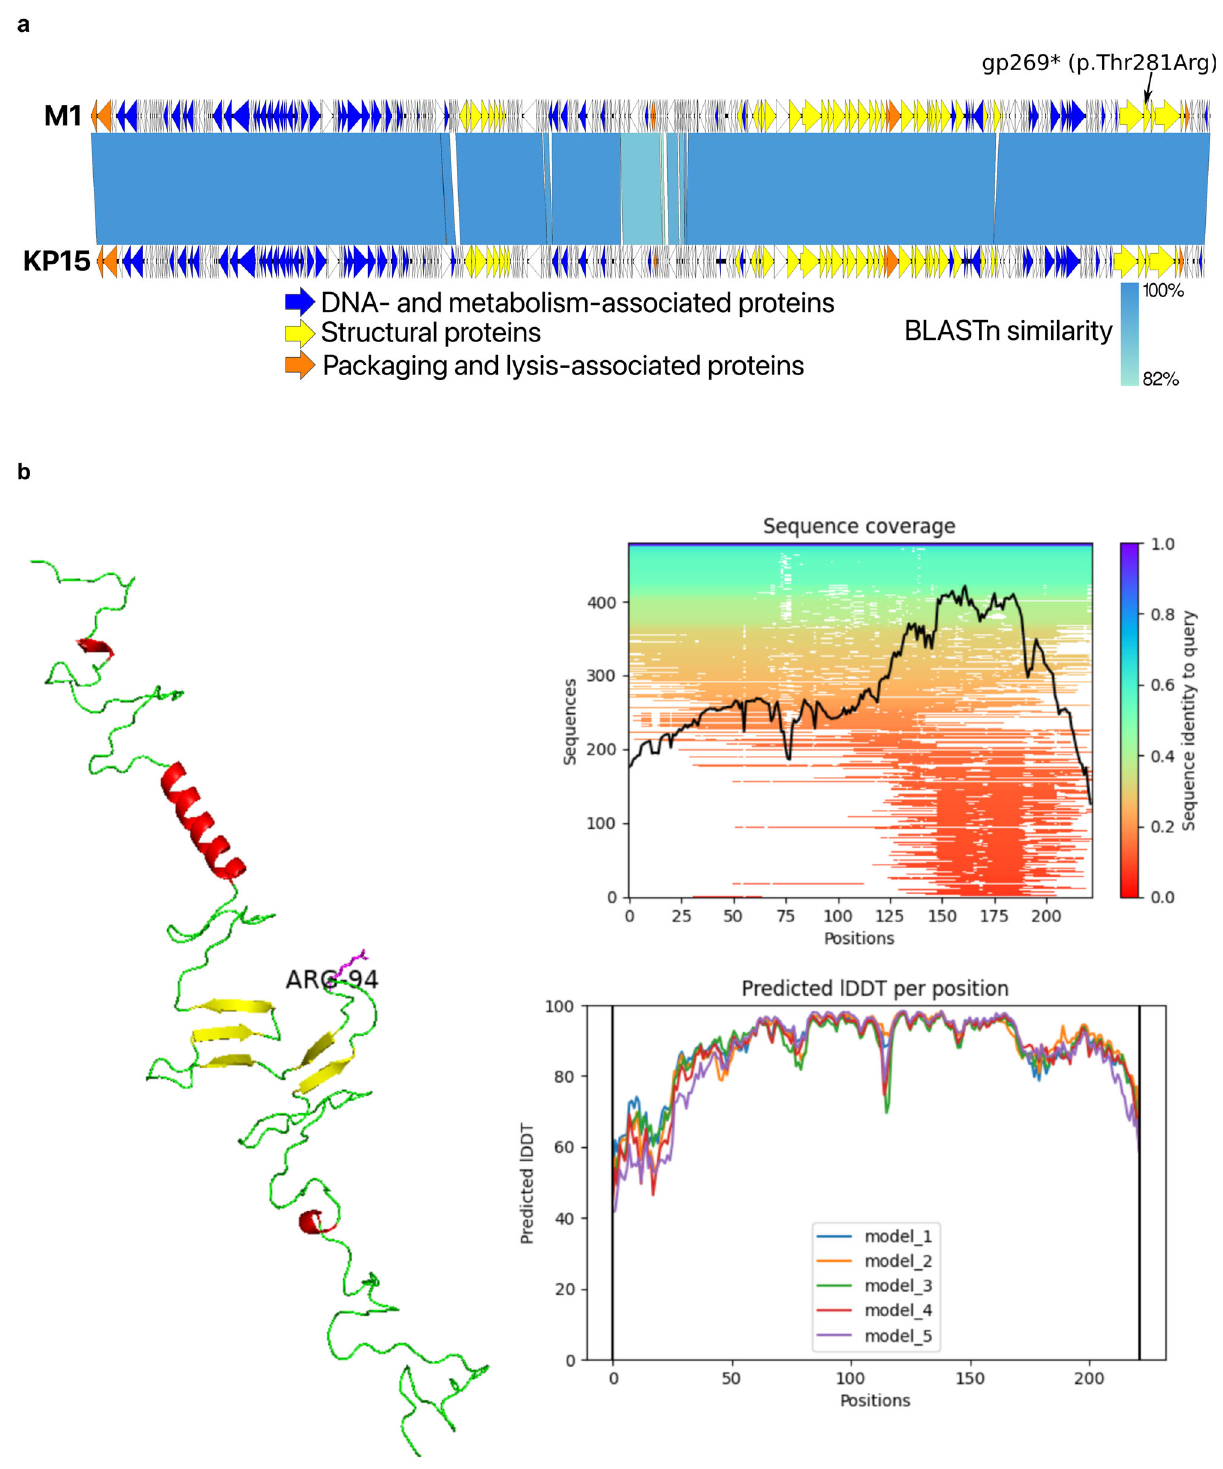
Fig. 3 Relevant genomic and proreomic characteristics of phage M1. Genome representation of phage M1 and comparison, using a BLASTn analysis, with Slopekvirus type species KP15 ( a ). Each white or colored arrow represents a predicted open reading frame. In orange, genes encoding packaging and lysis-associated proteins are displayed, in yellow structural proteins and in blue DNA- and metabolism-associated proteins (adapted from EasyFig 2.2.2). The single missense mutation found in the preadapted phage M1 isolate used for therapy is indicated (gp269). AlphaFold2 model of the hinge connector of the distal tail fi ber ( b ). The mutation of a Threonine to an Arginine is indicated (position 94). Alpha helices are indicated in red and beta sheets in yellow. Green stretches exhibit no speci fi c structures. The model quality scores are presented to the right of the model. lDDT local distance difference